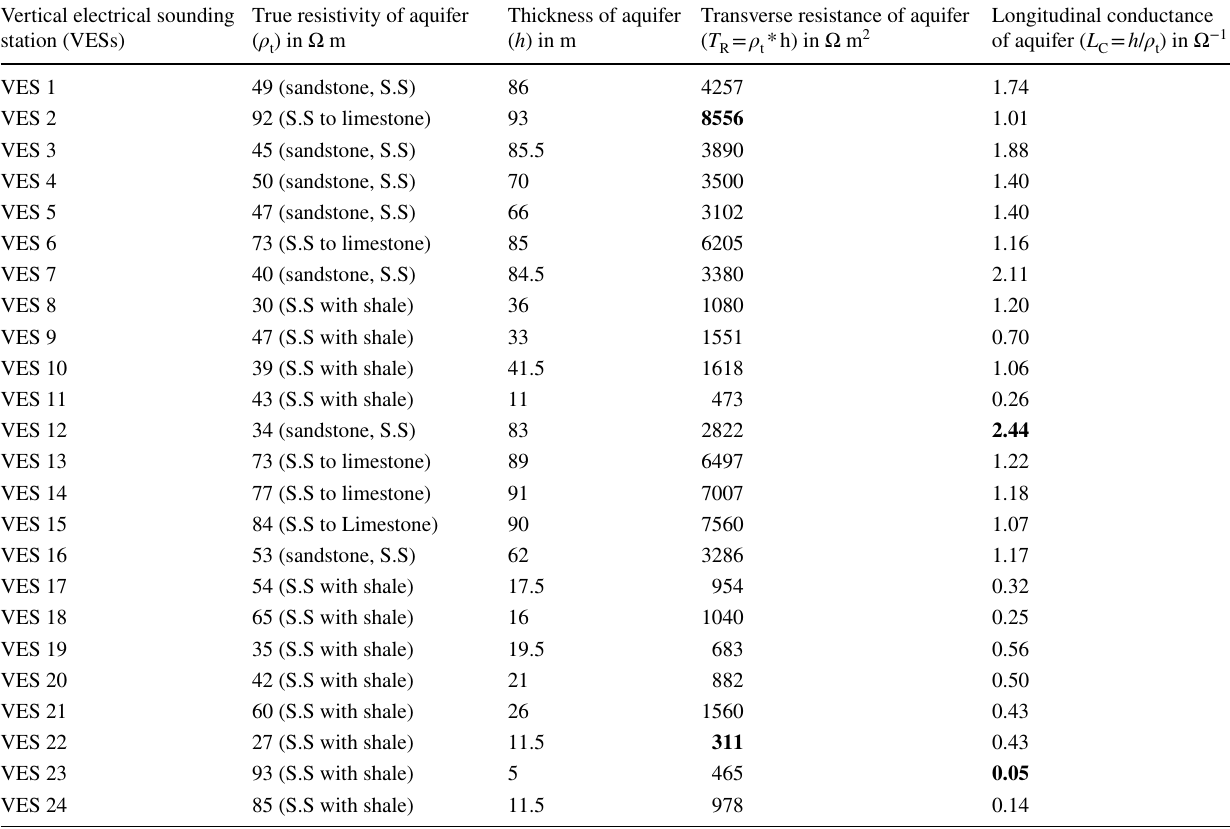
2 and the longitudinal conductance ( L R ) in Ω m